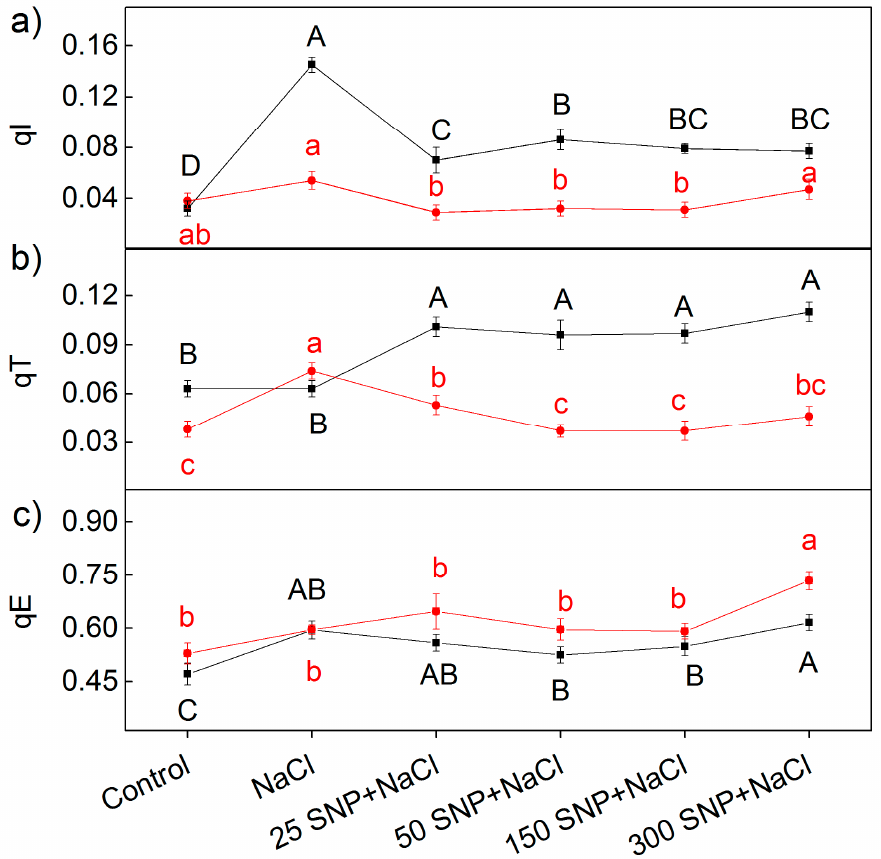
Figure 7. Effects of SNP on the components of non-photochemical quenching: ( a ) qI (photoinhibitory component), ( b ) qT (state-transition component), and ( c ) qE (energy-dependent component) for the leaves of the two sorghum varieties (Albanus—black and Shamal—red symbols) under salt stress. Mean values ( ± SE) were calculated from eight independent measurements. The significant differences among treatments at p < 0.05 are indicated by different letters (uppercase for Albanus and lowercase for Shamal).